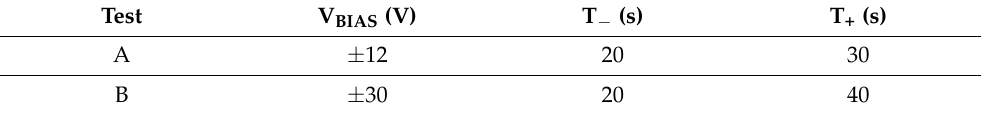
Table 1. Experimental configuration for the alternating bias tests.